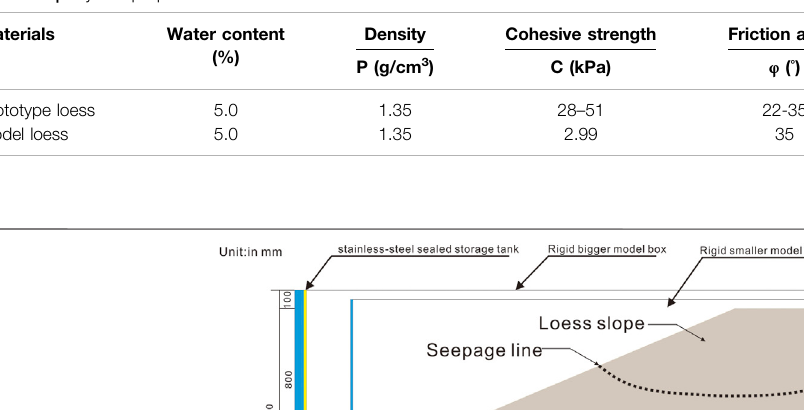
TABLE 1 | Physical properties of the tested loess.